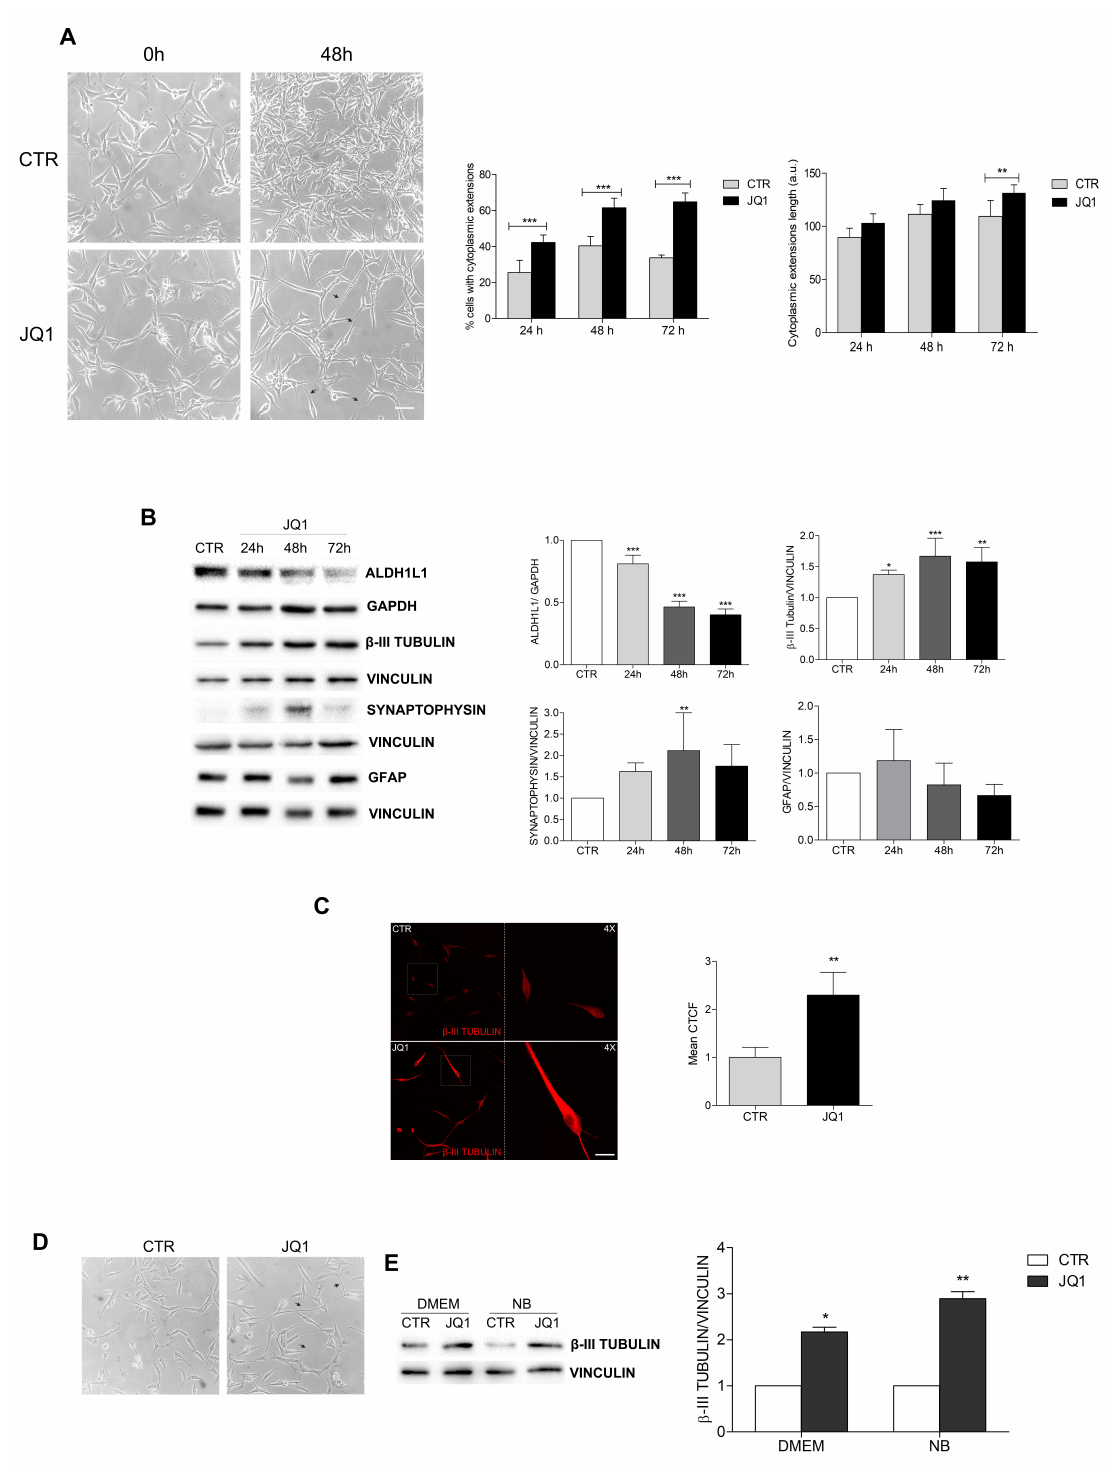
Figure 4. BET inhibition induces differentiation in U87 cells. ( A ) U87 cells were cultured in complete DMEM (CTR) or in the presence of 0.5 µ M of JQ1 and phase contrast pictures at 20 × magnification were taken at 24, 48, and 72 h. Representative images of the cells upon 48 h of JQ1 stimulation are shown. The arrow heads in the pictures indicate cytoplasmic extensions. Scale bar: 100 µ m. The percentage of cells with cytoplasmic extensions and the extension length were calculated by Image J analysis and are shown in the graphs. At least 10 fields per each condition were counted. ** p < 0.01 and *** p ≤ 0.001, two-way ANOVA. ( B ) Western botting analysis was performed on the protein extracts of the U87 cells cultured as in ( A ). Specific antibodies for ALDH1, β III-TUBULIN, SYNAPTOPHISIN, and GFAP were used, and representative images are shown. GAPDH,